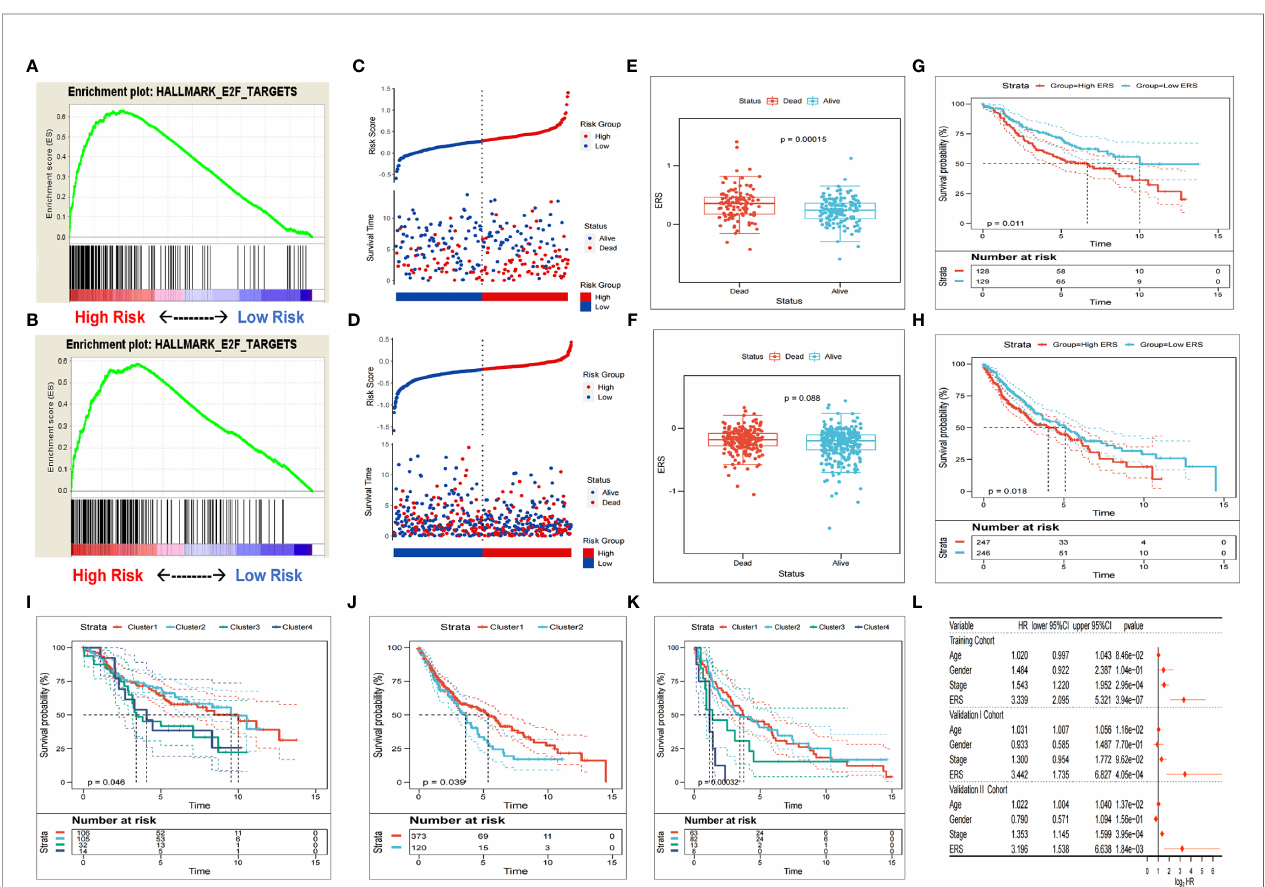
FIGURE 4 | Veri fi cation of gene signatures in different sets. (A, B) GSEA validated E2F pathway enrichment in the validation I and II sets. (C, D) The dead patients in the validation I and II sets showed higher ERS. (E, F) The patients of the high-ERS group in the validation I and II sets had worse survival. (G, H) Patients with higher ERS have a poorer prognosis in the validation I and II sets. (I – K) On the basis of the expression patterns of gene signature, the survival rate of clusters derived from consensus clustering differed greatly. (L) Multivariate Cox regression analysis showed ERS as an independent risk factor for OS in the validation I and II